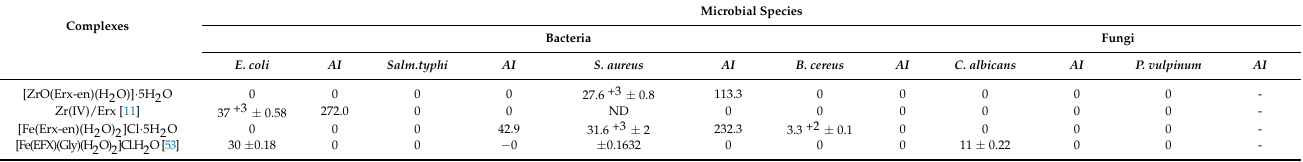
Figure 3. Activity index of H 2 Erx-en and its metal complexes. Table 7. The comparison between Zr(IV) and Fe(III) complexes in our complexes and some previous works.